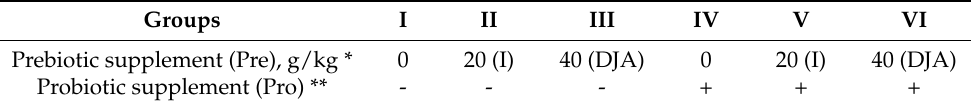
Table 1. Experimental